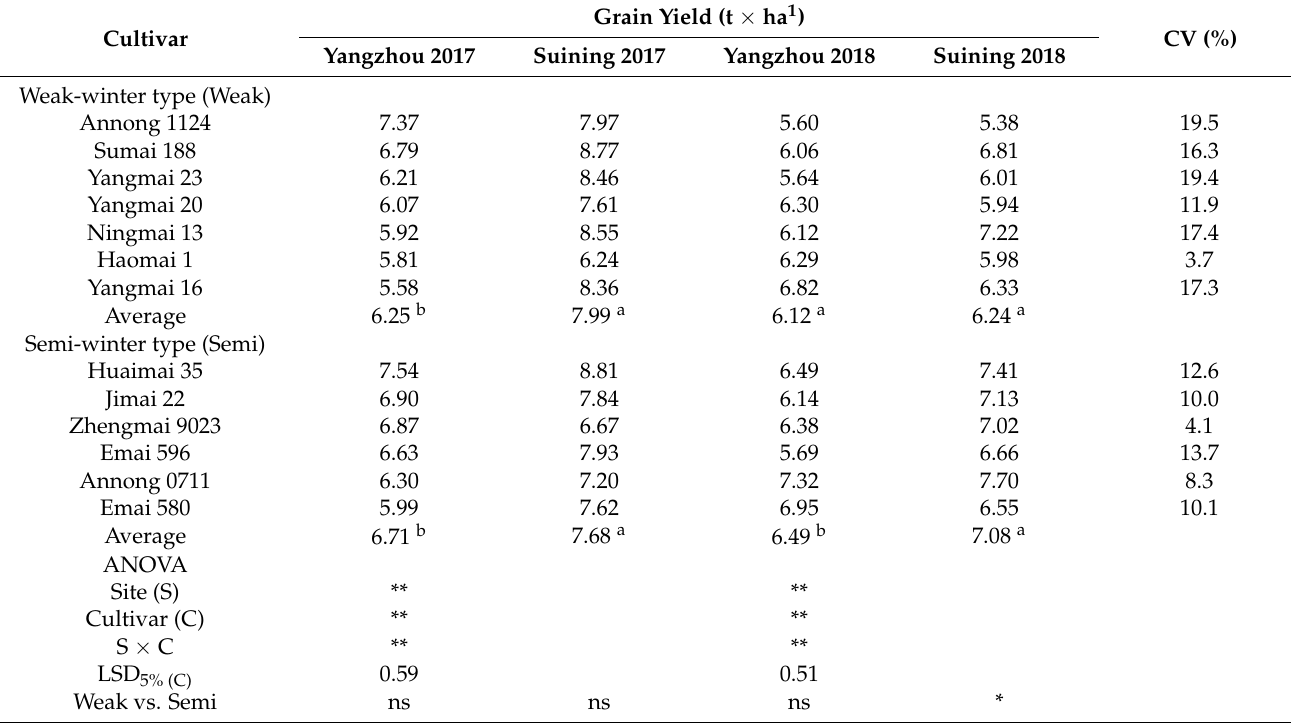
Table 3. Grain yield (t ha − 1 ) of weak-winter-type and semi-winter-type cultivars planted in southern (Yangzhou) and northern (Suining) areas of the Yangtze River basin, China, in 2017 and 2018.